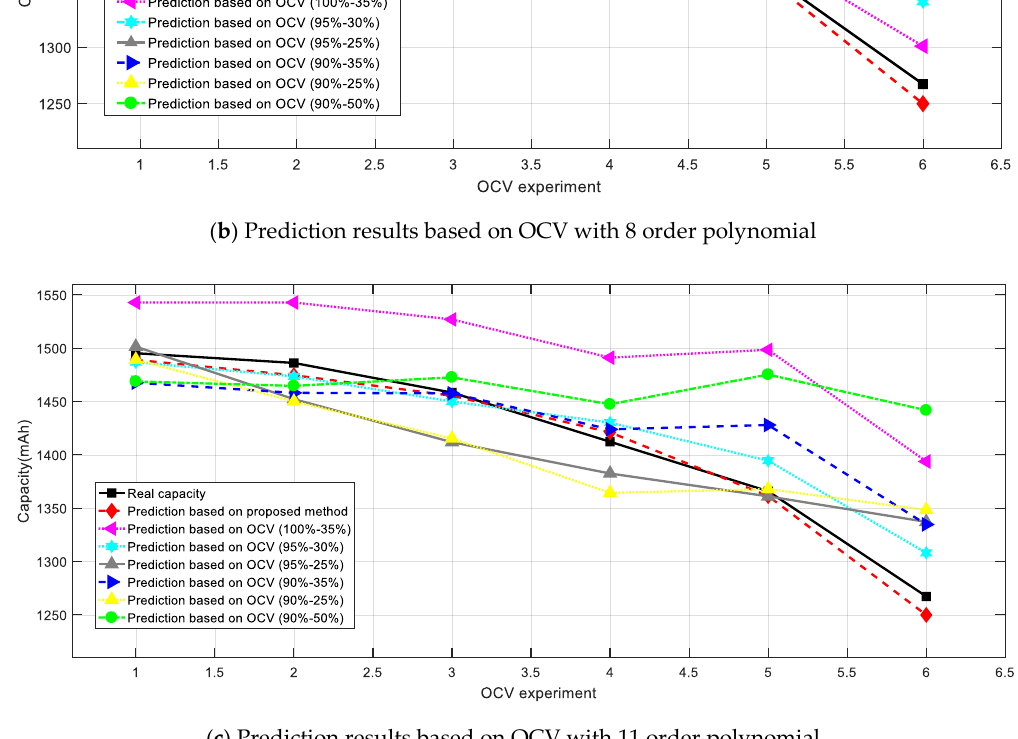
Figure 13. Capacity Prediction.